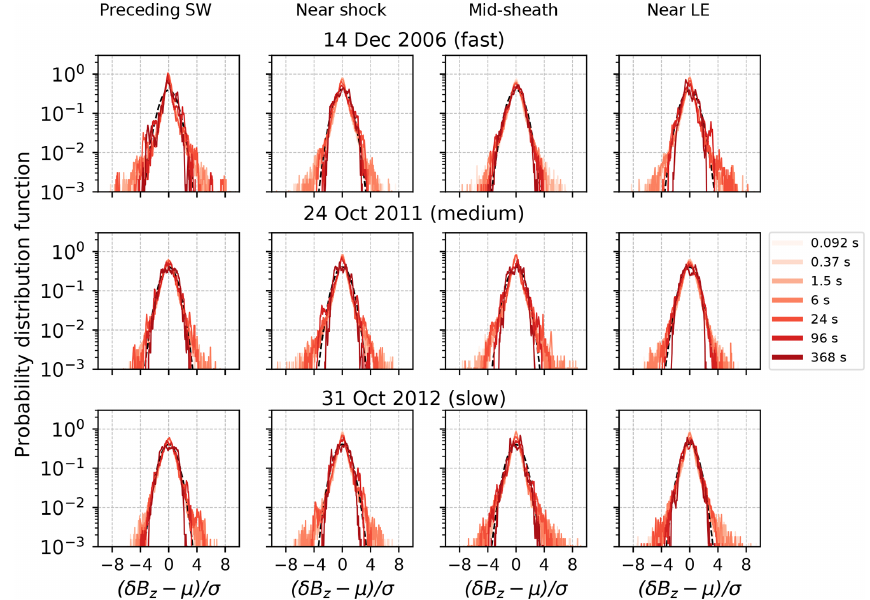
Figure 4. Probability distribution functions of (δB Z − µ)/σ (where µ is the average and σ is the standard deviation of δB Z calculated over a 15min sliding window) for different timescales (cid:49)t (shown as curves in different colours) for (top) 14 December 2006, (middle) 24 Oc- tober 2011, and (bottom) 31 October 2012 events. The leftmost columns give the results for the solar wind preceding the shock, and the following three columns give the results for three different sheath subregions. The black dashed line shows the Gaussian for 6s